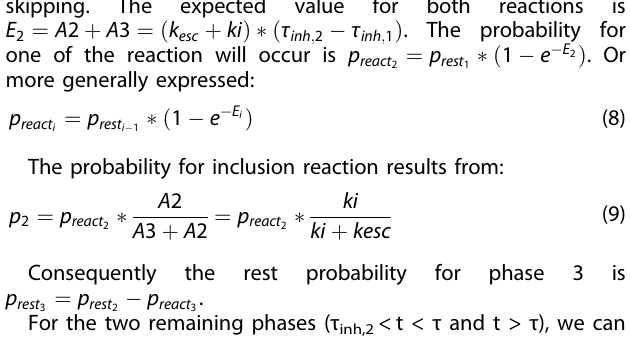
mentary Table 1. The fi rst step is the calculation of p1 representing the probability for inclusion within the fi rst phase dt1 , in which commitment to skipping is not possible (t < τ inh,1 ). Assuming a Poisson process, we can calculate the expected value E 1 ¼ A 1 ¼ ki (cid:4) τ inh ; 1 , showing the amount of expected inclusion reactions within the phase 1 ( dt1 = τ inh,1 ). Assuming an